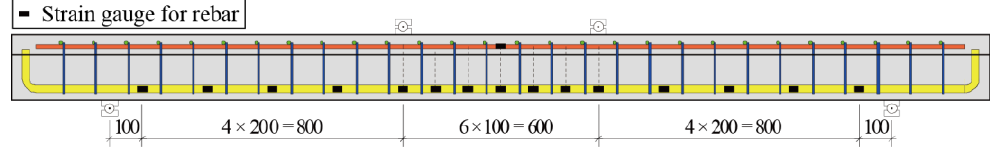
Figure 7. Locations of strain gauges on the rebar.